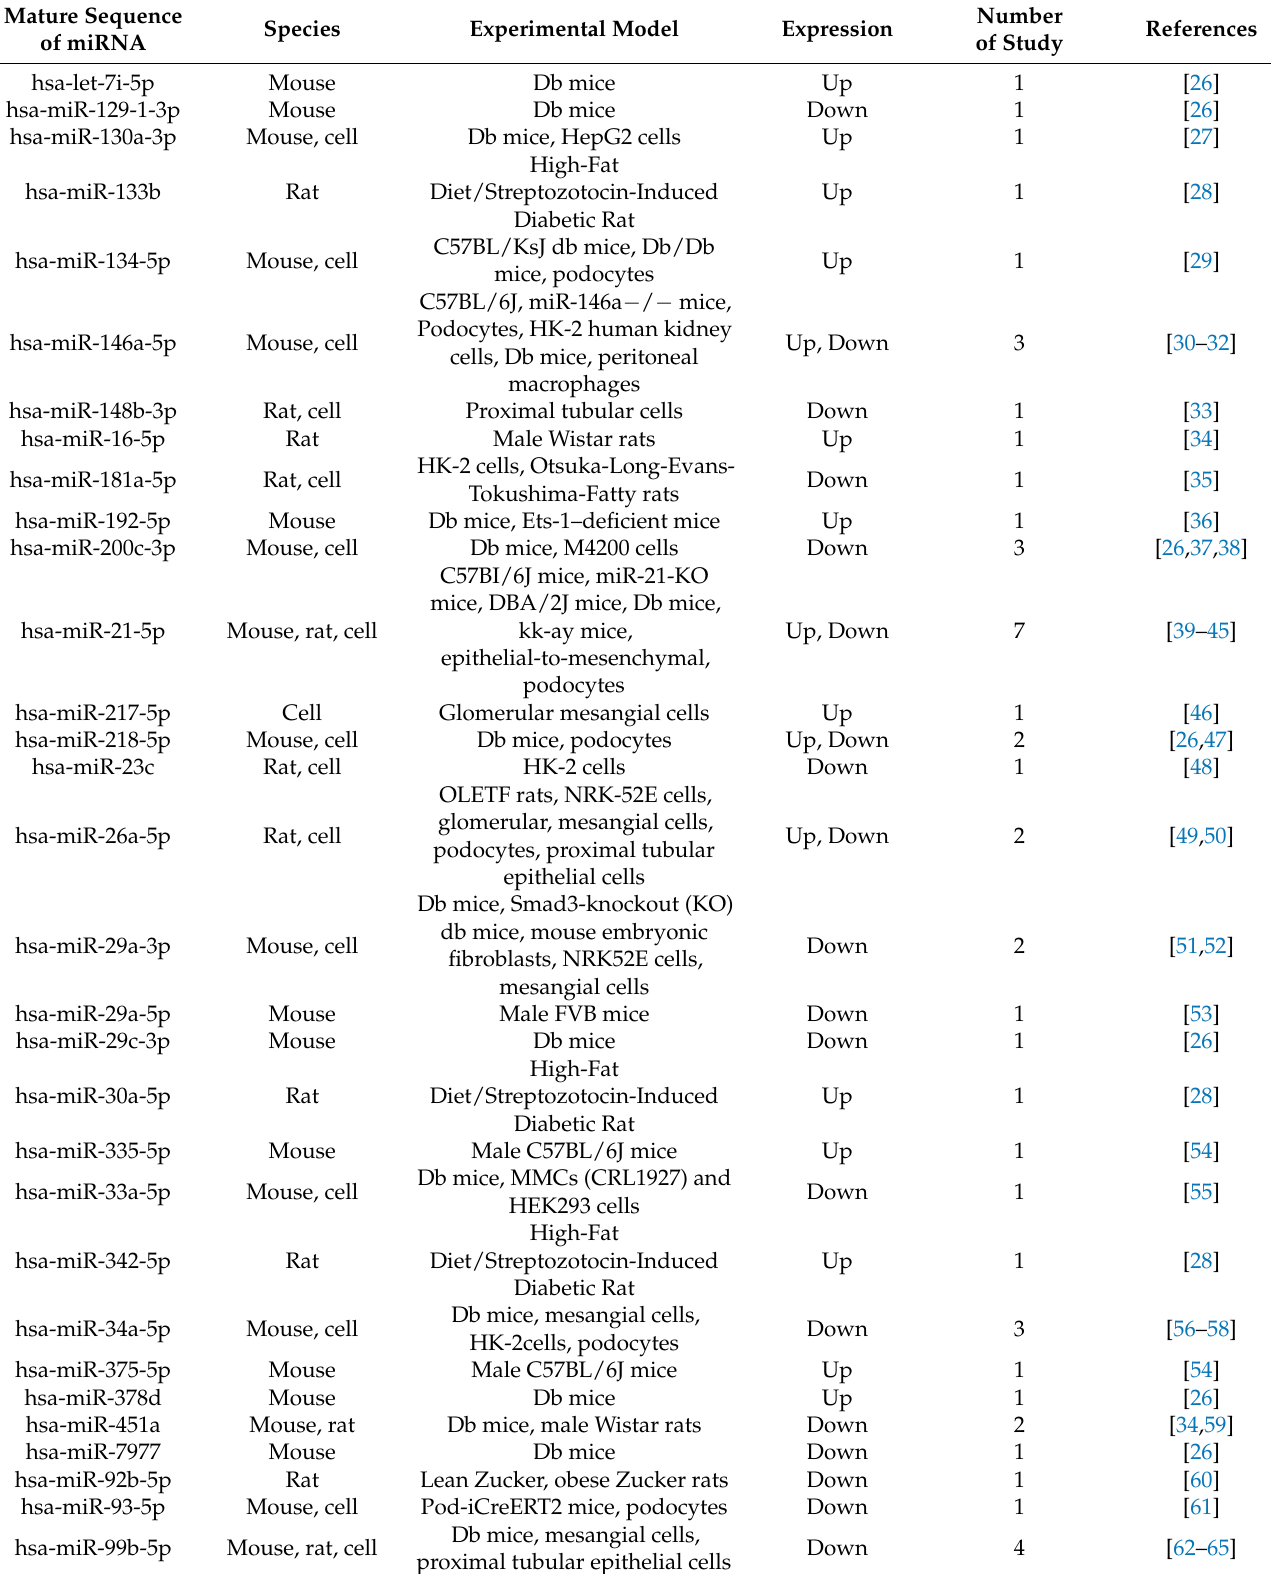
Table 1. miRNA implicated in the diabetic animal